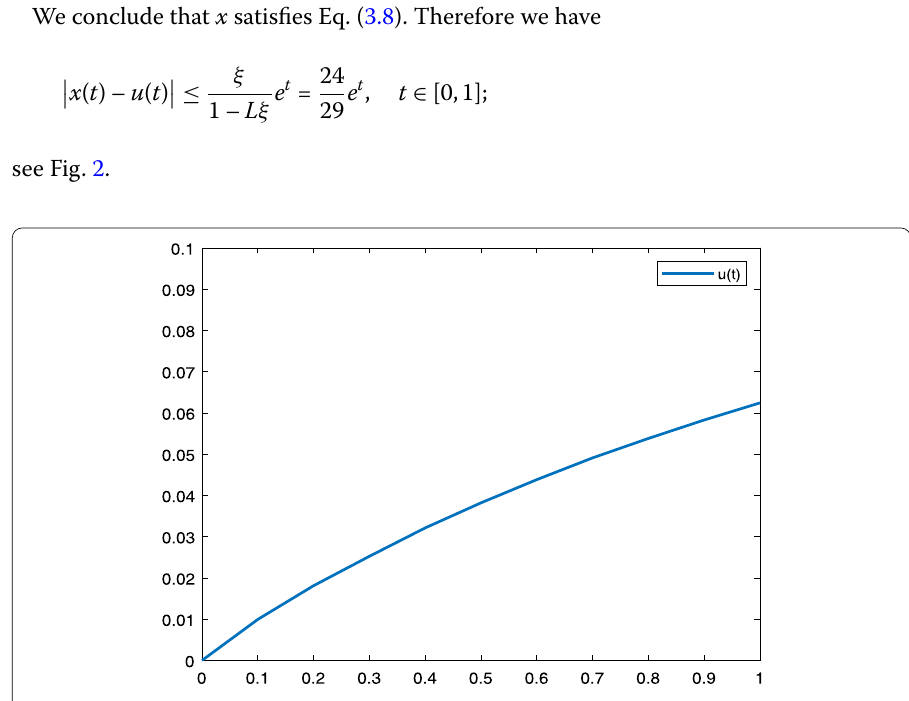
Figure 1 The solution u ( t ) of Eq. (4.1) with initial value condition u (0) =